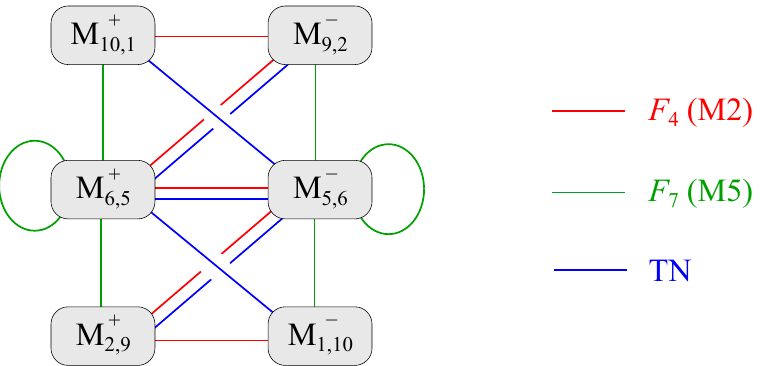
Figure 7 . The possible signature-changing domain walls in M-theory, classi(cid:12)ed by the theories they connect and the (cid:13)ux supporting them, where F 7 = ?F 4 indicates that the magnetic (cid:13)ux F 7 has a leg perpendicular to the interface, rather than the electric (cid:13)ux F 4 . For each (cid:13)ux, we indicate the type of negative brane which sources it. TN denotes the Taub-NUT geometry with linear potential V / x .